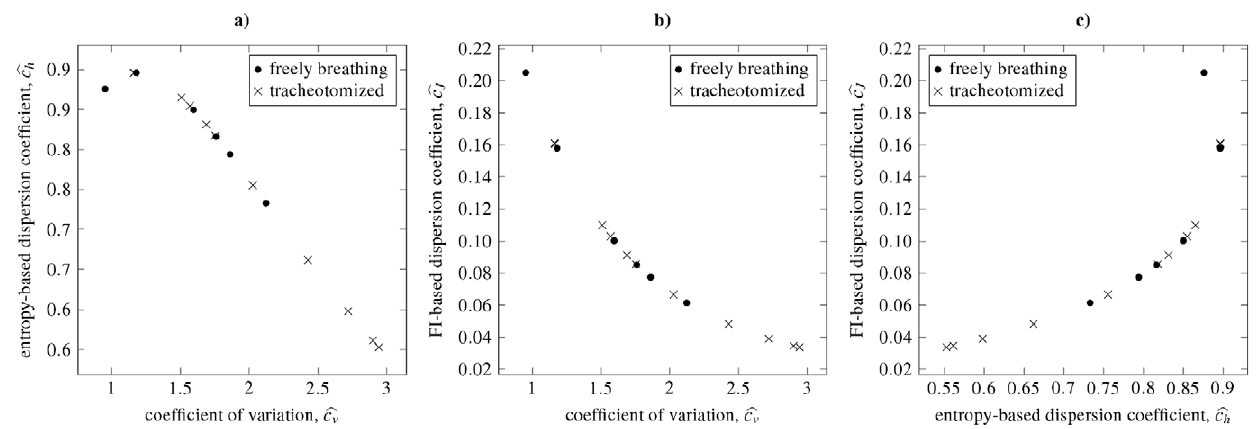
Figure 11. Dependencies between different dispersion coefficients for the same experimental data as in Fig. 10. The data was fitted by inverse Gaussian distribution and from maximum likelihood estimators of its parameters the dispersion coefficients were computed. Two categories of data are distinguished: tracheotomized and freely breathing rats. There are small differences in the two categories, as quantified by all the three coefficients. See Figs. 3, 4 and 5 for inverse Gaussian distribution to see the complete curves of the dependencies.